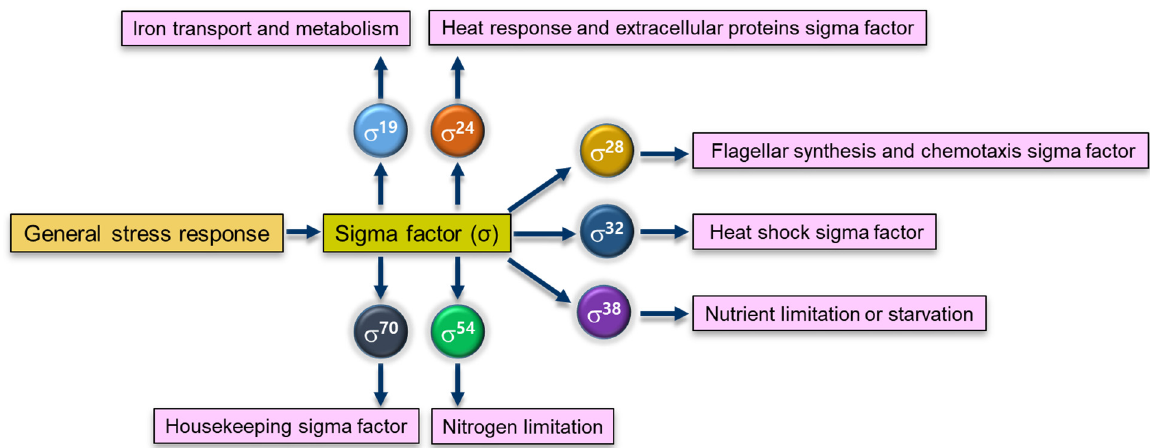
Figure 3. Sigma factors involved in the regulation of general stress responses.